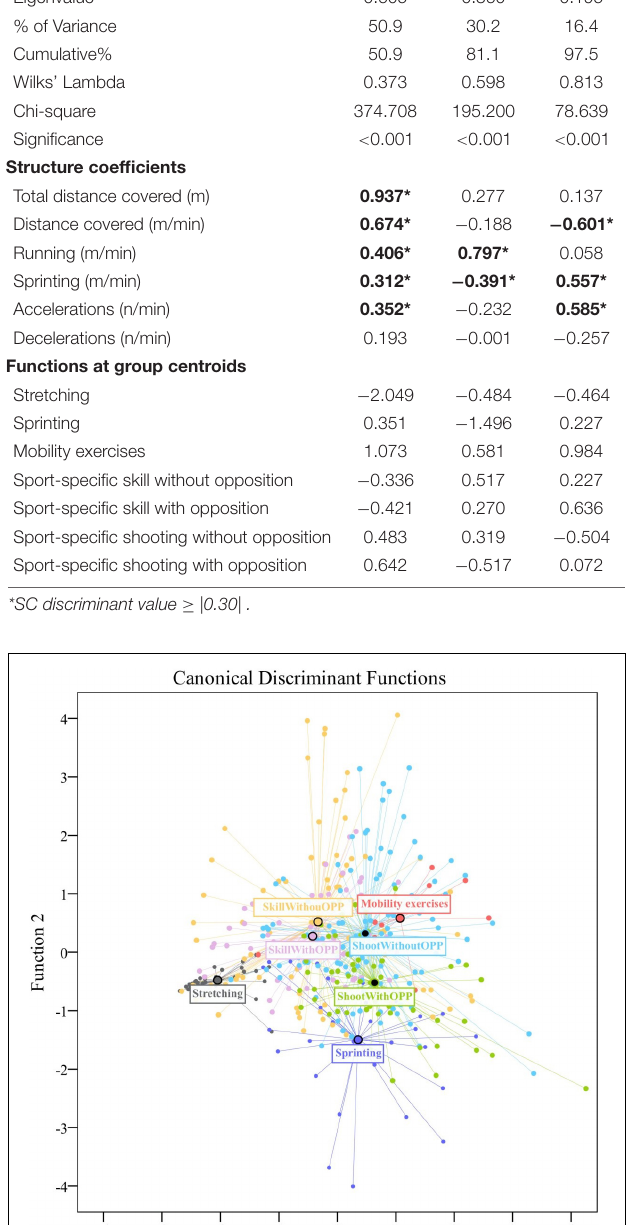
with opposition such as SSG or rondos with different area and numerical relations that precede sport-specific shooting exercises. These routines typically progress from